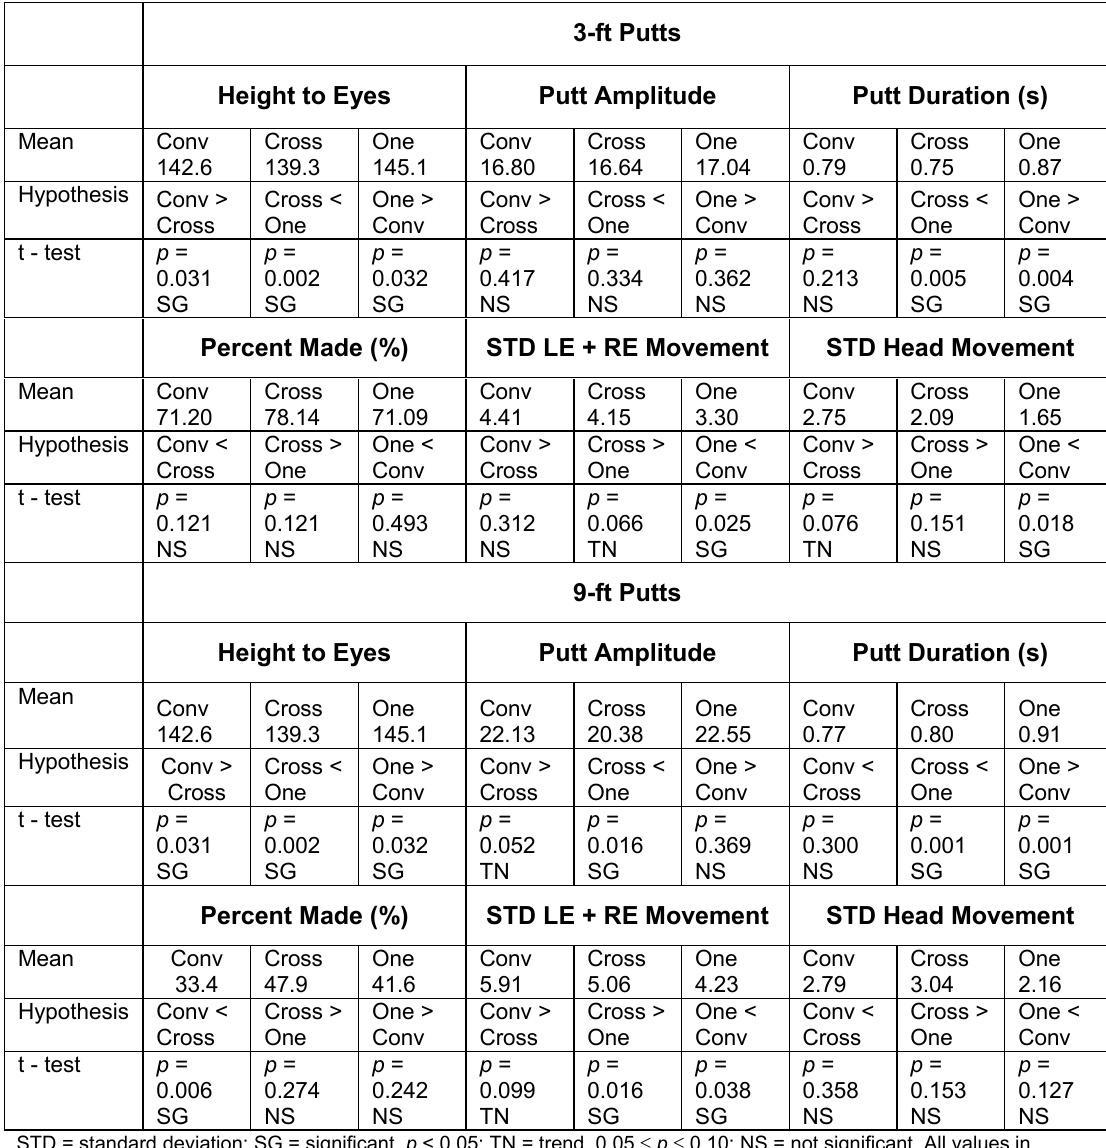
Comparisons Among Conventional (Conv), Cross-Hand (Cross), and One-Handed (One) Grips for the Averaged Data in Seven Subjects Using the t-Test (One Tail, Significance Level Set at p = 0.05) for 3- and 9-ft